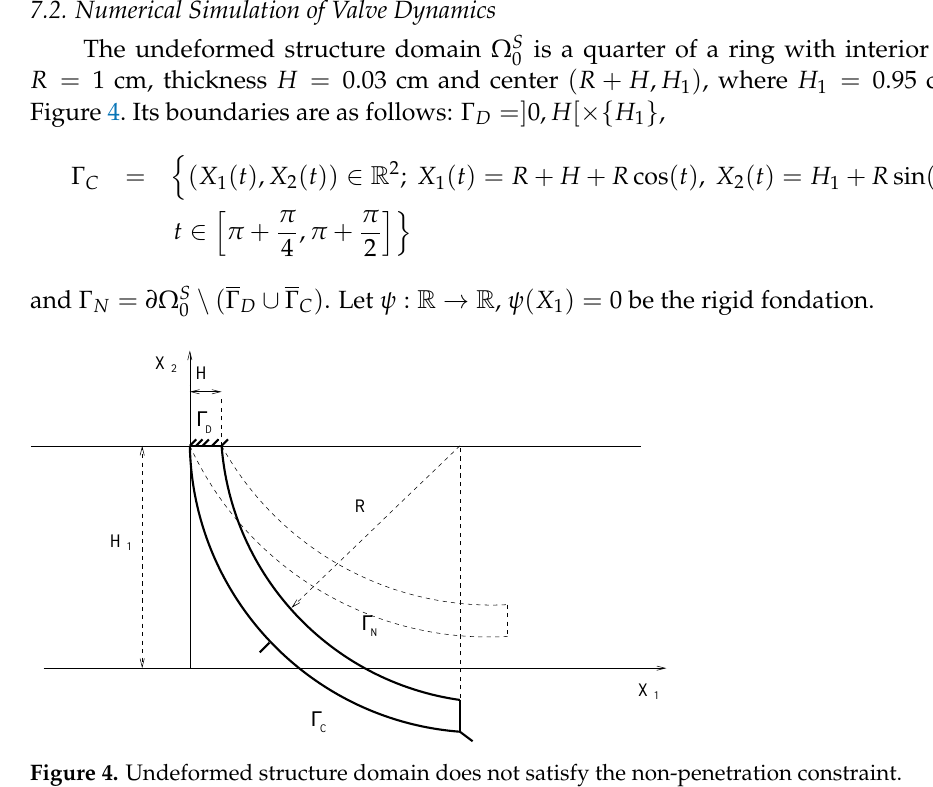
Figure 4. Undeformed structure domain does not satisfy the non-penetration constraint.